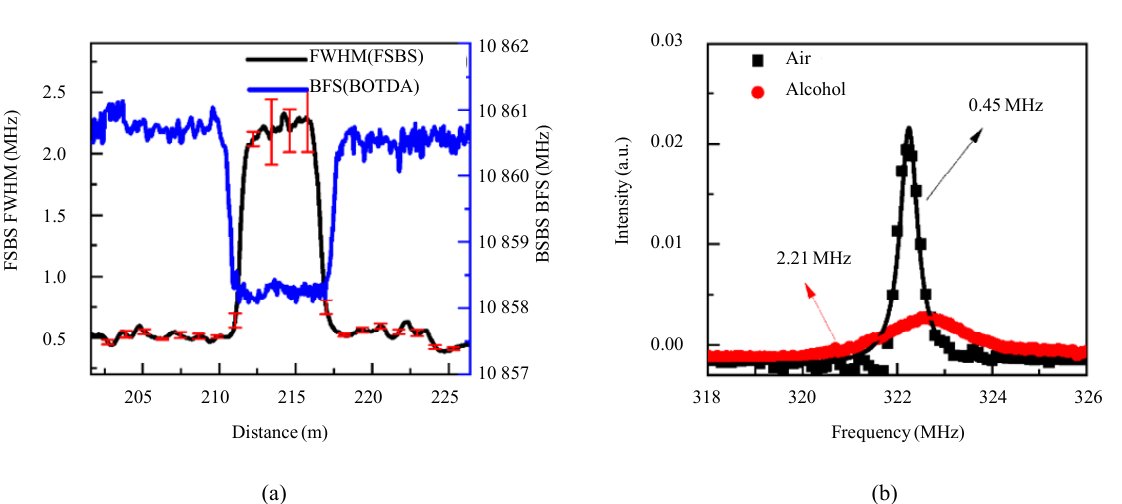
Fig. 17 Position-resolved substance identification with FSBS: (a) measured linewidth of FSBS and (b) measured FSBS spectra